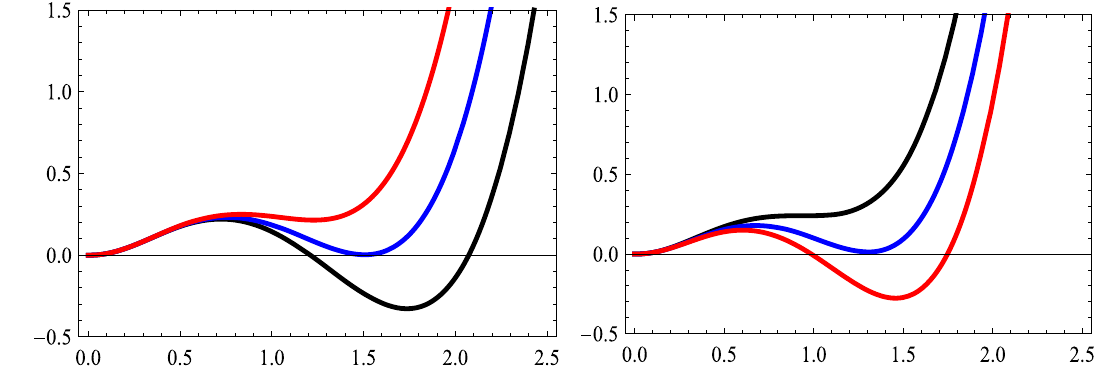
, b = 1 , (cid:20) = 1 , r = 1 , m = 8 , (cid:18) = − 1 , q = 1. Left: α = 2 and a = 1 . 1(black) , 1 . 129(blue) , 1 . 17(red). Fig. 6 B ( r ) versus r for ν = − 2 0 3 Right: a = 1 . 25 and α = 2 . 005(black) , 2 . 0133(blue) , 2 .